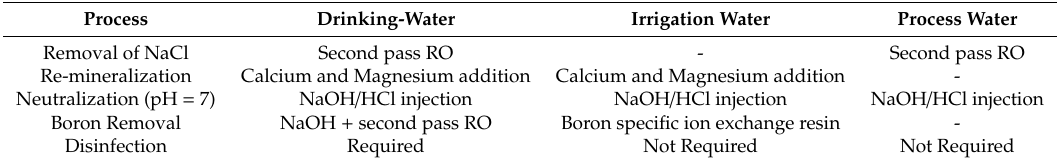
Table 3. Post-treatment processes required for various applications [18] [Copyright © 1998–2019 Lenntech B.V. All rights reserved].